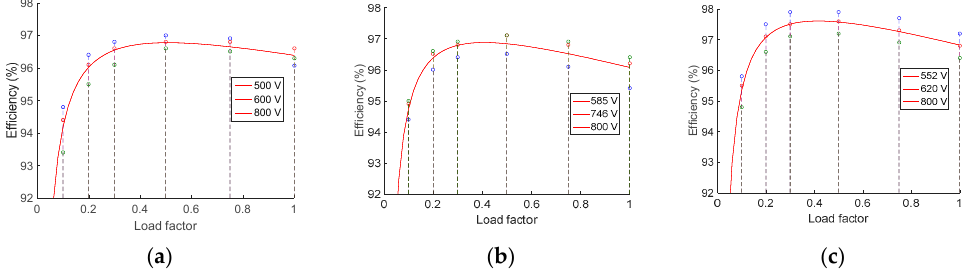
Figure 4. Efficiency curves calculated by means of the Jantsch model. ( a ) Perfect Galaxy International Ltd. EQX0250UV480TN. ( b ) Power-One ULTRA-750-TL-OUTD-4-US ( c ) Power Electronics FS0900CU.